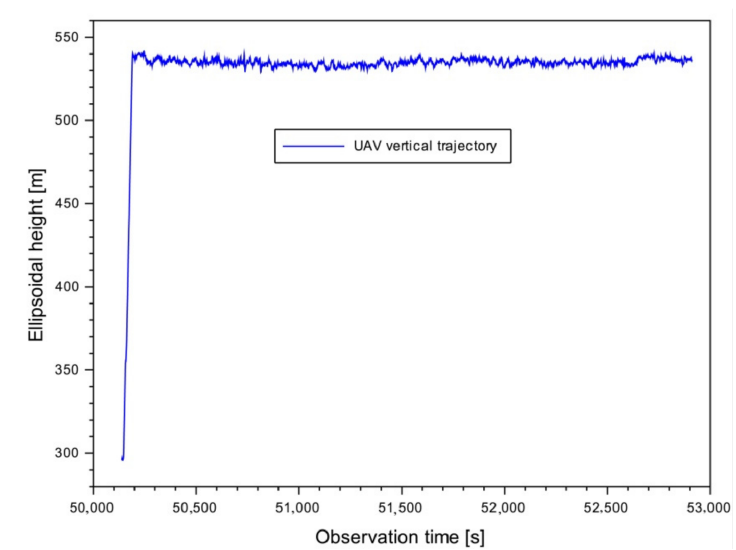
Figure 2. The UAV horizontal trajectory.